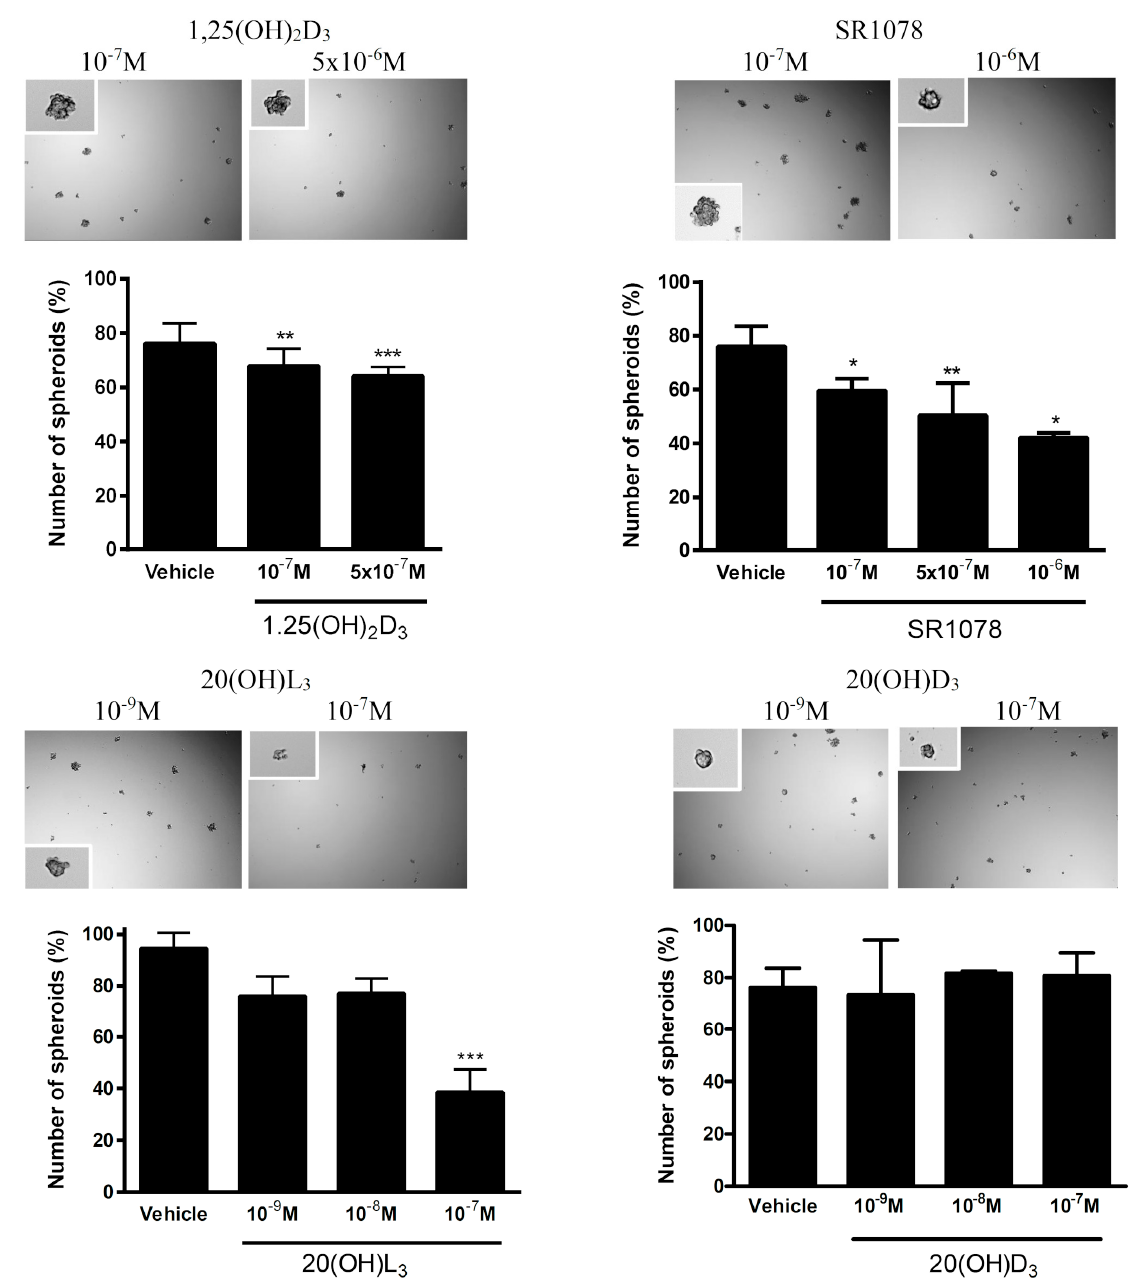
Figure 9. Effect of 1,25(OH) 2 D 3 , 20(OH)D 3 , 20(OH)L 3 , and SR1078 spheroid formation by SKOV-3 ovarian cancer cell line ( n = 3). Data are presented as a percentage of the control. Statistically significant differences are denoted with asterisks as determined by ANOVA (* p < 0.05, ** p < 0.01, and *** p < 0.001). Images present representative spheroids, and insets present high-magnification images of single spheroids.